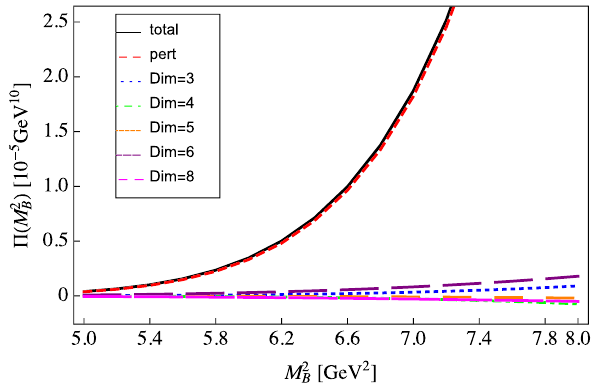
Fig. 1 OPE convergence for the current J 1 in the J P = 0 + bc ¯ q ¯ s